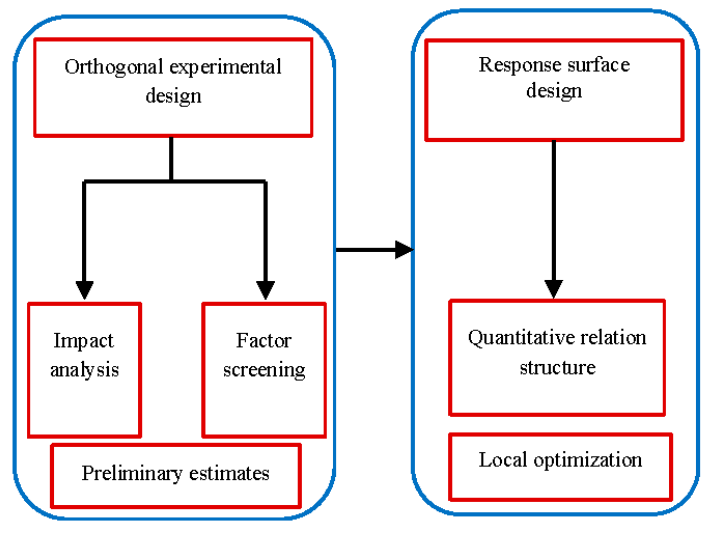
Figure 3. Idea of the experimental design.